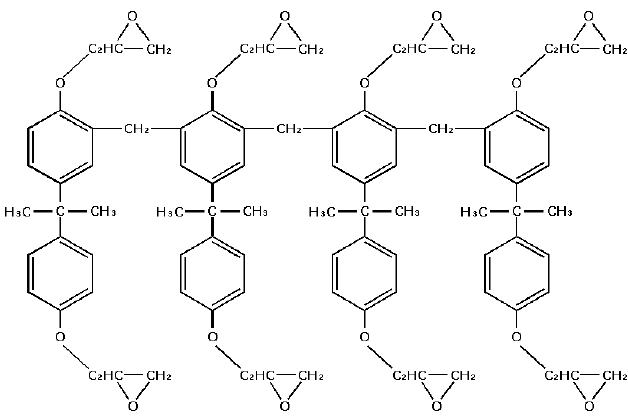
Figure 1. SU-8 molecule with epoxy groups.